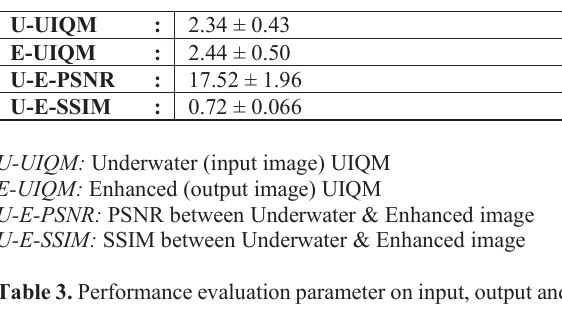
Table 2. Performance evaluation parameter on input, output and